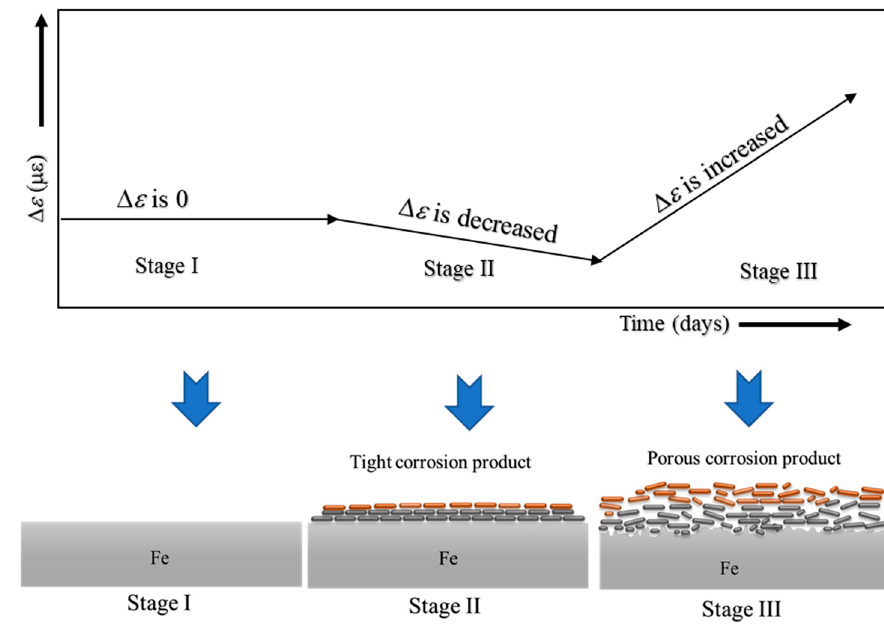
Figure 10. Mechanism of corrosion behavior based on strain measurements.